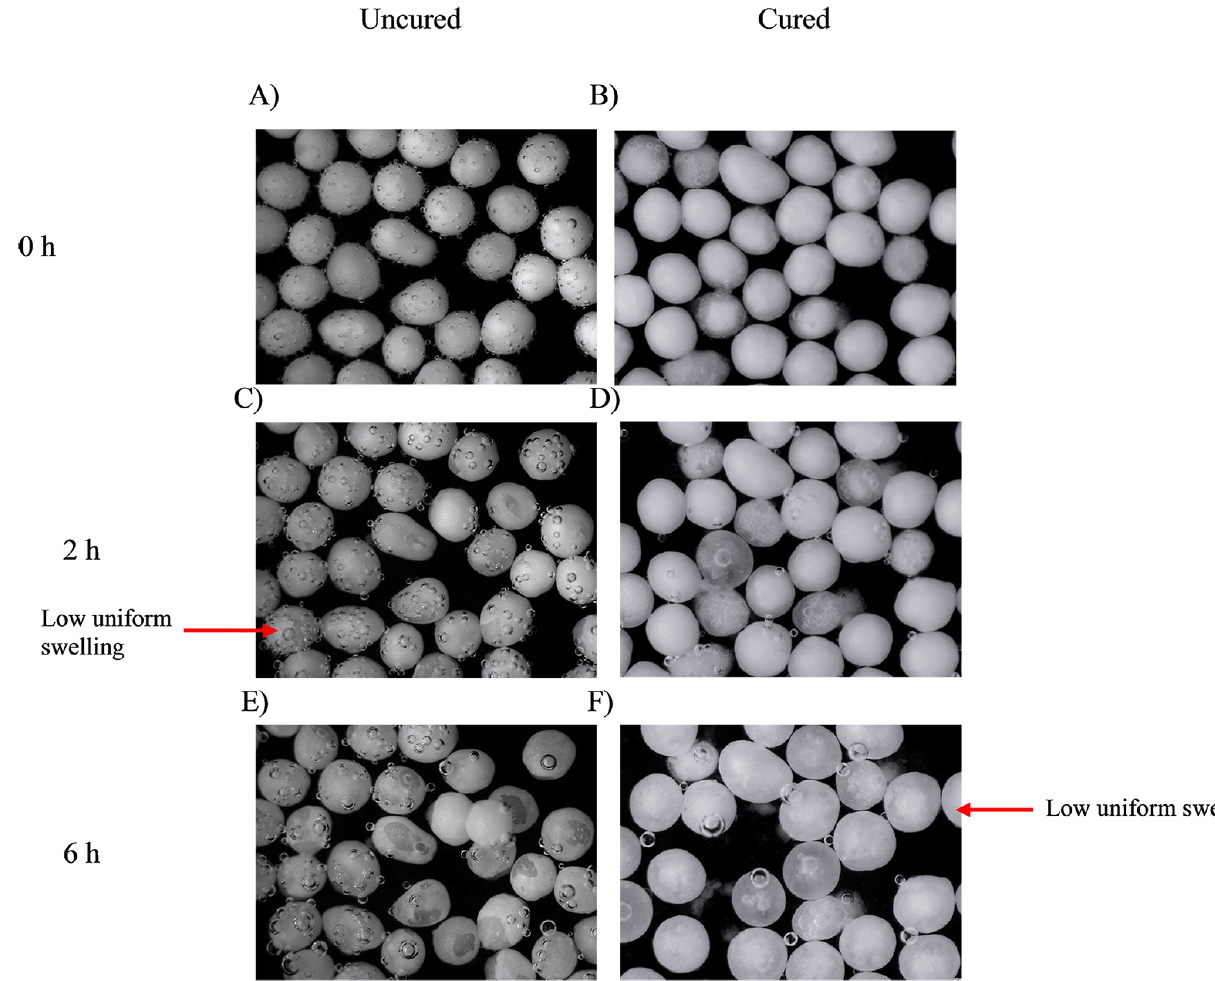
FIGURE 11 - Macroscopic pictures of uncured and cured (60 °C/75% RH/24 h) pellets based on sugar cores loaded with 10% propranolol HCl coated with Eudragit ® NE 30D: Aquacoat ® ECD (25:75) using 35% talc as a function of time in 0.01 N